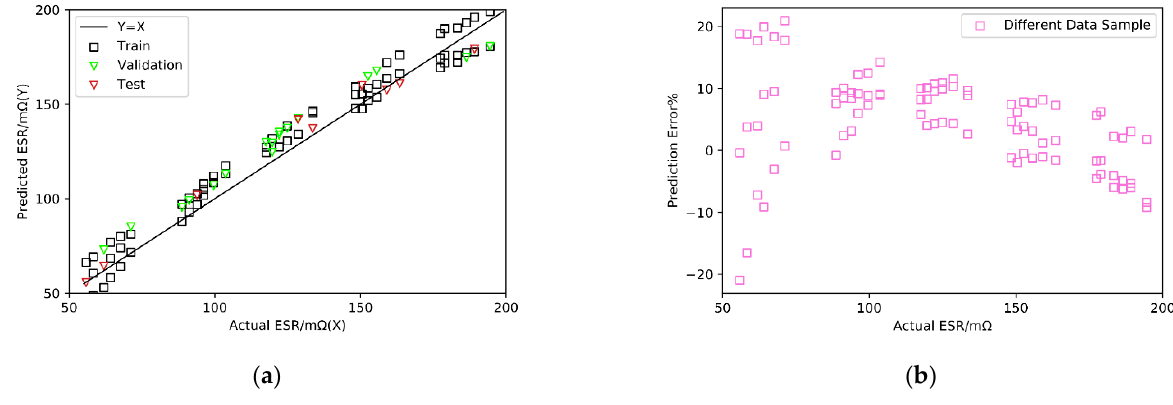
Figure 13. ESR Estimation results under experiments by SVR ( a ) a best fitting showing train, test and validation results; ( b ) cross validation showing PEs for 10 fittings under 10 random data divisions.